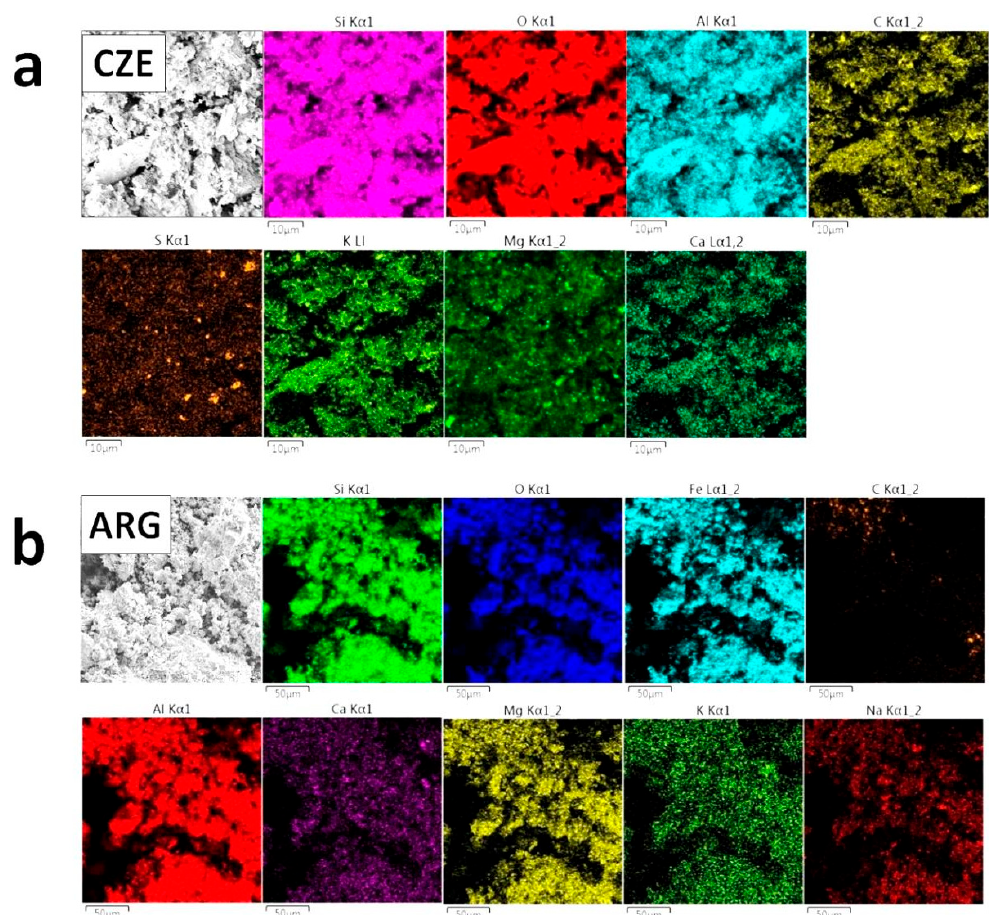
Figure 3. Elemental distribution maps of the major elements in ArgCW ( a ) and CzCW ( b ) obtained by energy dispersive spectroscopy (EDS). Scale bar is 10 µ m and 50 µ m, respectively.